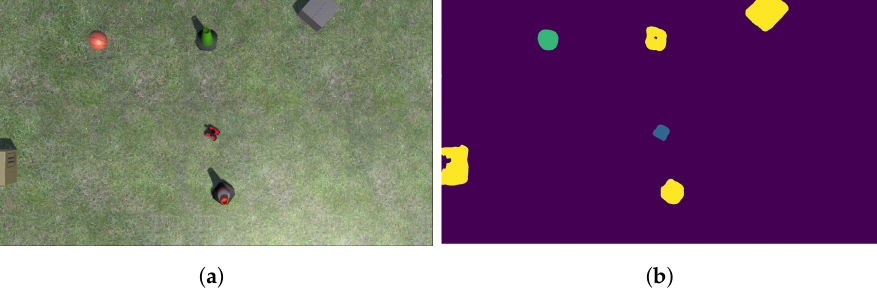
Figure 10. ( a ) An example Unity image. ( b ) The resulting mask from the best performing model.